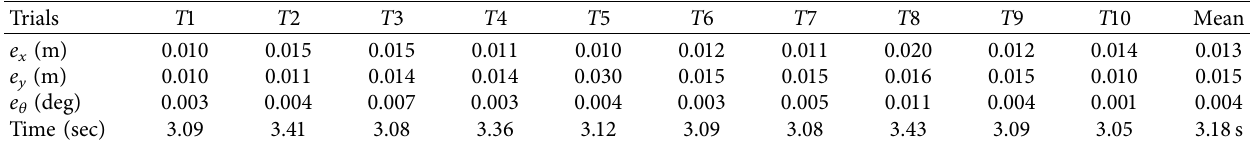
Table 16: The mean of ten trials with the PF (two landmarks-non-Gaussian noise).